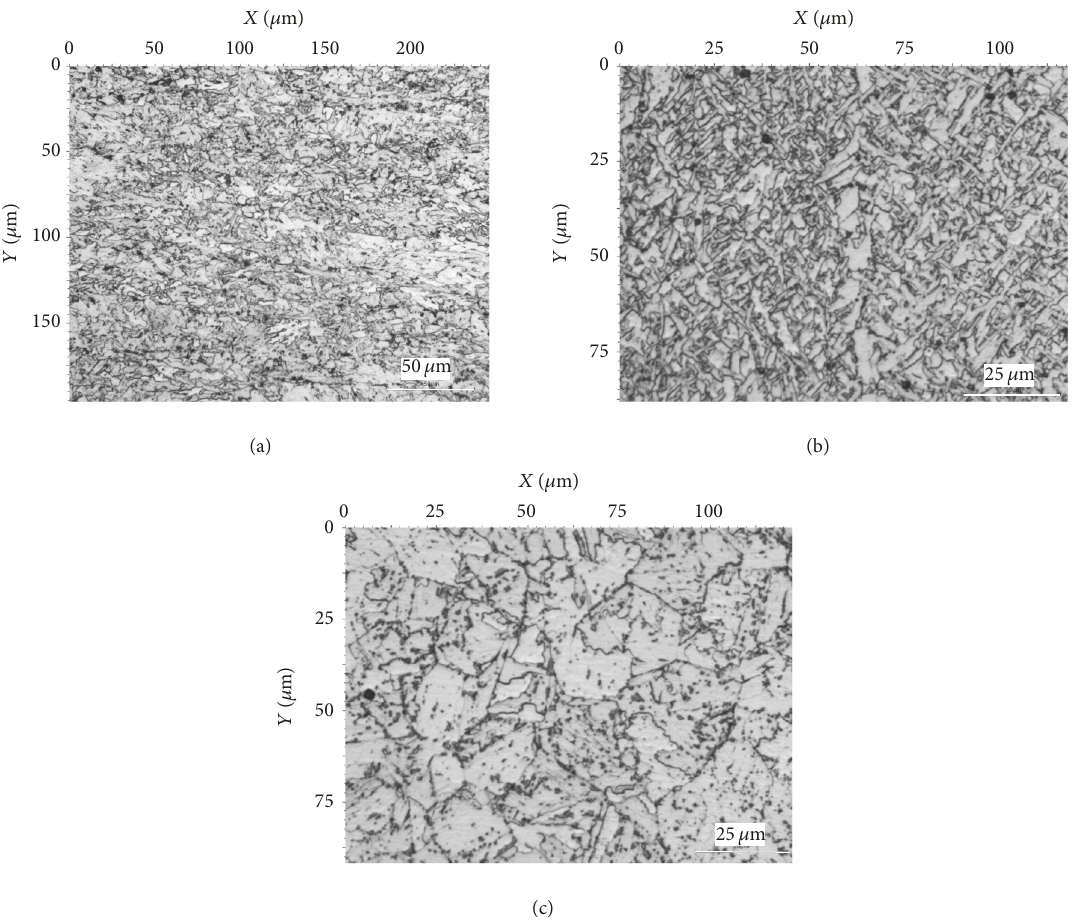
Figure 5: Microstructure of welded joint within (a) BM ( × 500), (b) WM ( × 1000), and (c) HAZ ( ×